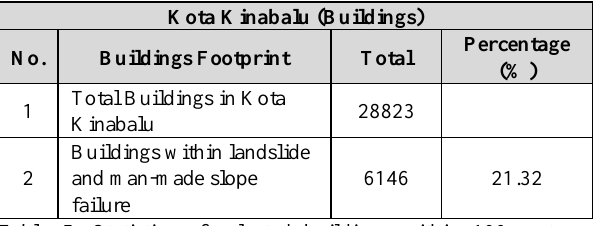
Table 5. Statistics of selected buildings within 100 meters